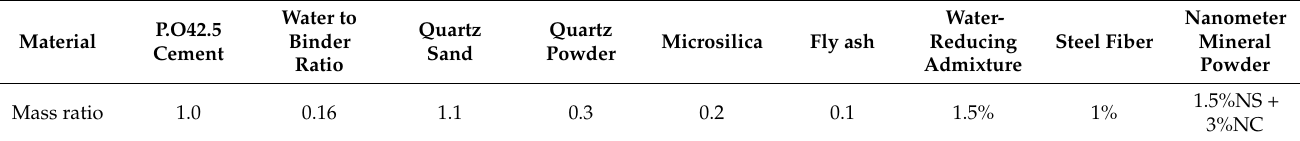
Table 4. The mix design of high-performance concrete.